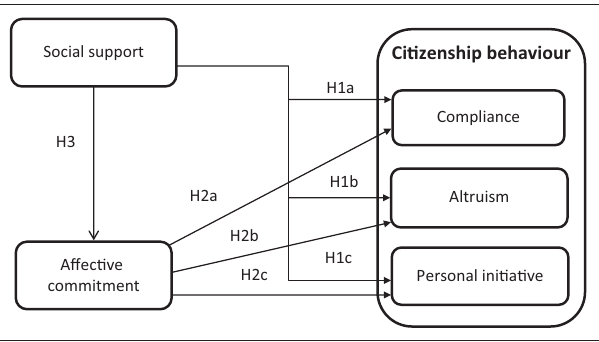
FIGURE 1: Organisational citizenship behaviour and its precursors in customer online